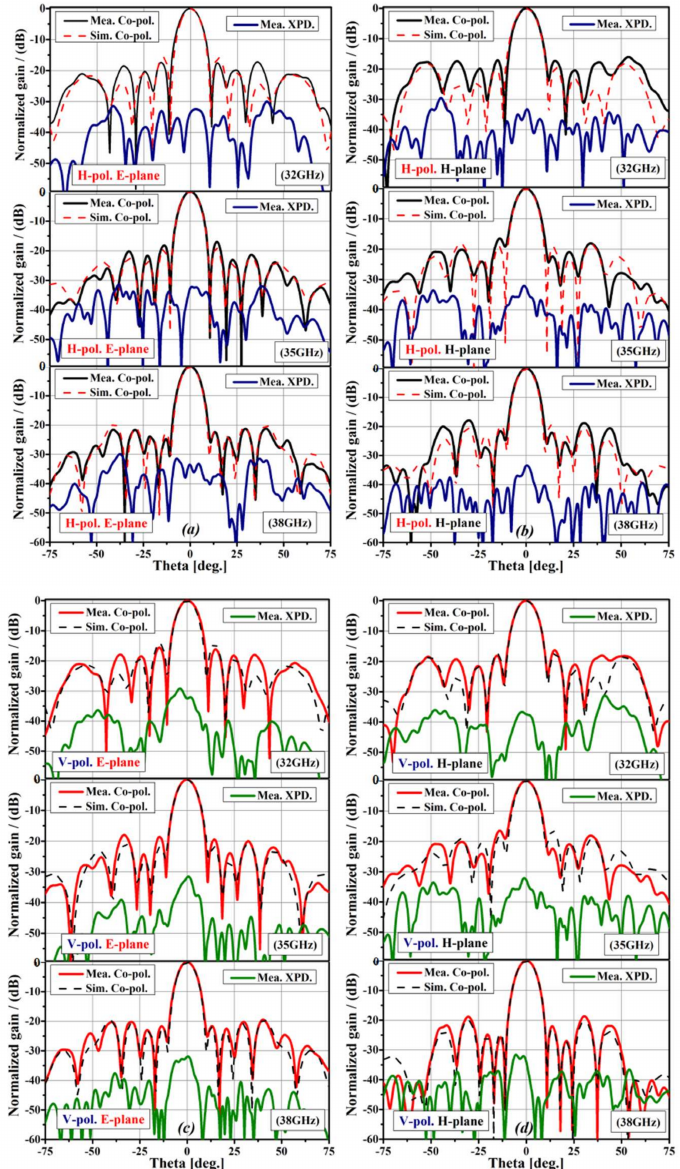
Figure 12. Measured and simulated radiation patterns of the 8 × 8-unit dual-polarization ME-dipole antenna array: ( a ) H-pol. E-plane; ( b ) H-pol. H-plane; ( c ) V-pol. E-plane; ( d ) V-pol.